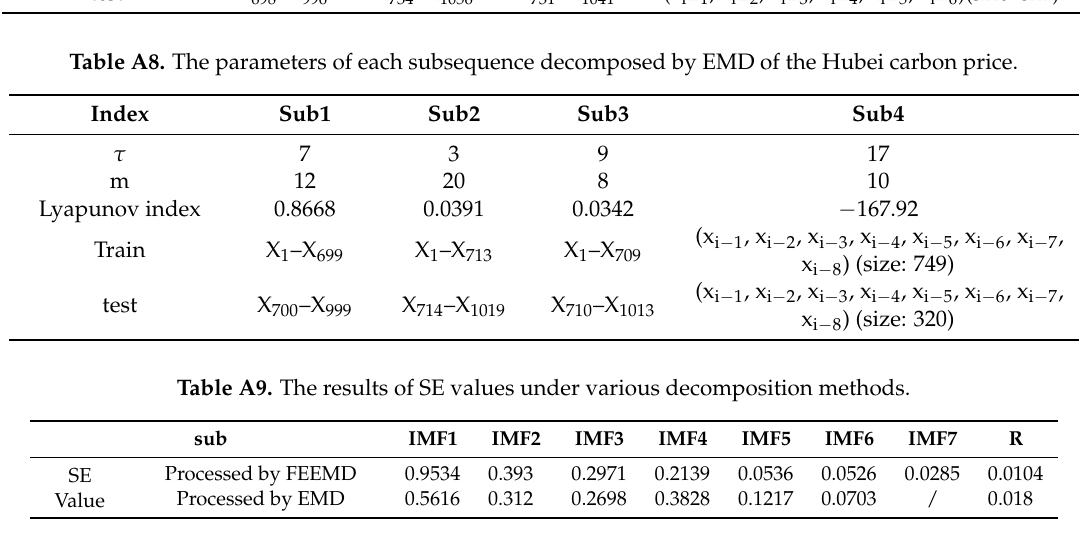
Table A10. The new subsequences divided according to the SE values.